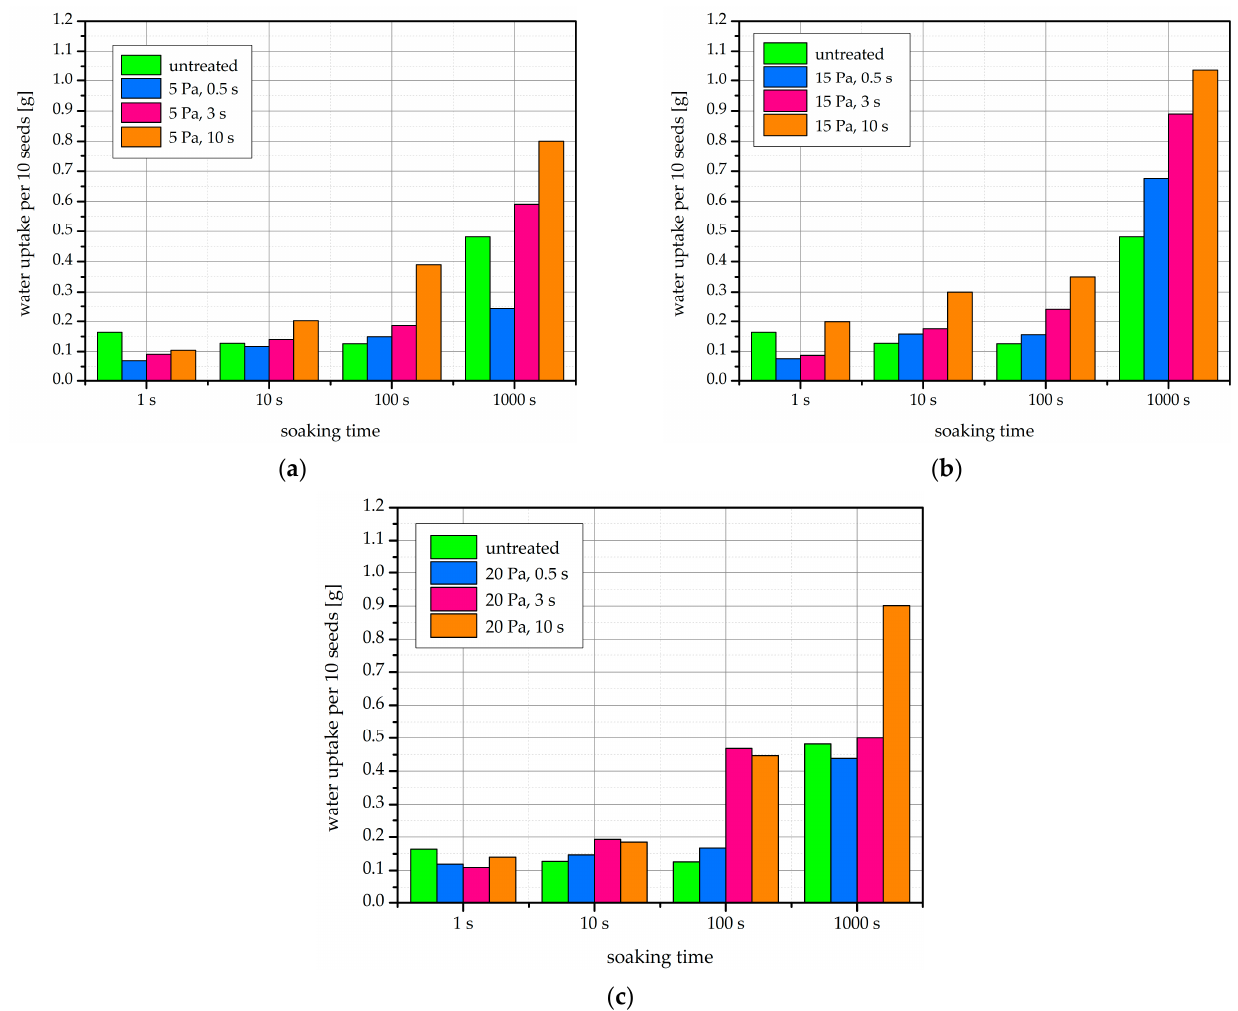
Figure 5. Water uptake of native and plasma-treated bean seeds expressed as g of water per 10 seeds soaked for different times (1–1000 s). Seeds were treated at ( a ) 5 Pa, ( b ) 15 Pa, and ( c ) 20 Pa.